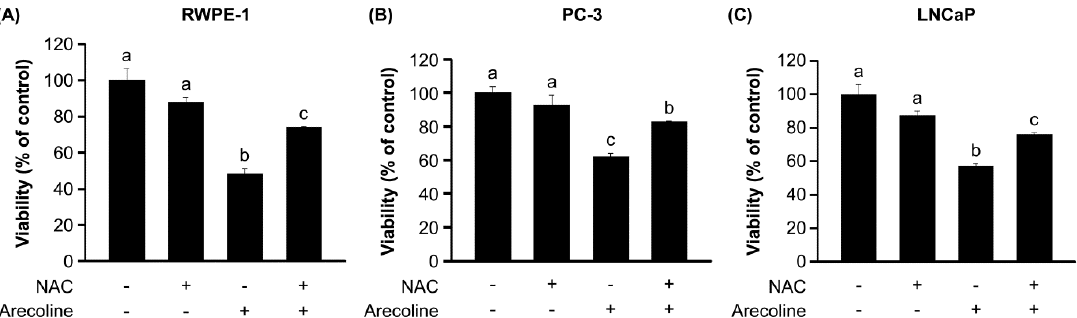
Figure 7. N-acetylcysteine (NAC) blocked the arecoline-induced changes in the viability of normal RWPE-1 ( A ) and cancerous PC-3 ( B ) and LNCaP (C) prostate cells. Cells were pretreated with NAC for 1 h and then exposed to 0.4 mM arecoline. After 48 h of treatment, we measured cell viability using an MTT assay. Data are expressed as the mean ± SEM from triplicate experiments. a-c Groups with different letters differ significantly ( p < 0.05). The symbols of “+” and “-“ were presented with or without addition of either arecoline or NAC, respectively.